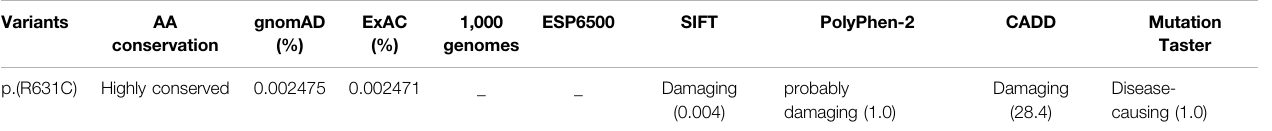
TABLE 2 | In silico analysis of the missense variant in CPT2 Variants